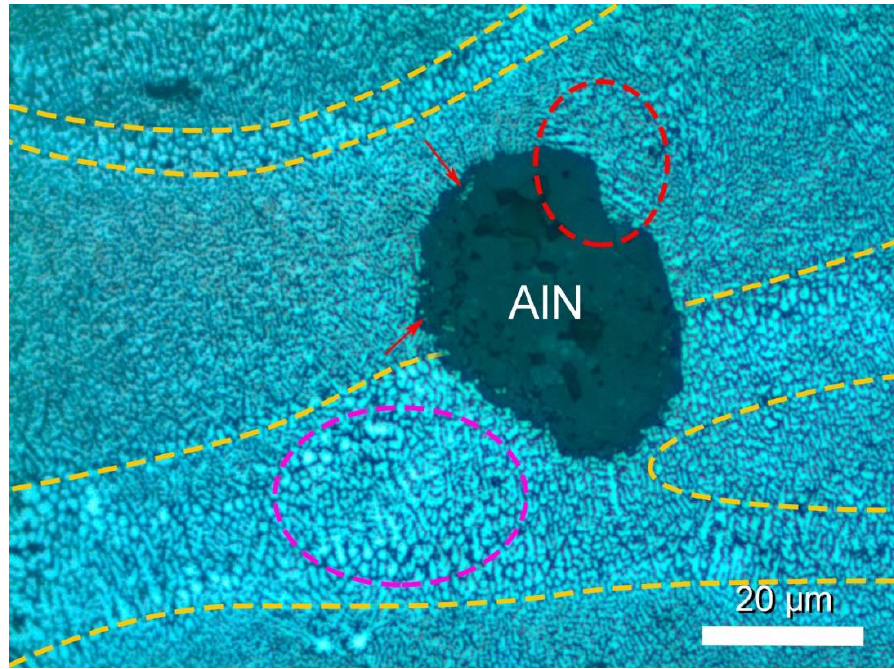
Figure 6. Optical microscopy image of the etched surface of AlSi10Mg/AlN composite after LPBF. The region highlighted by purple circle consists mostly of coarse cells caused by remelting during the LPBF process and, thus this region was reheated after solidification which induced the recrystallization process. Such a region is usually named a heat-affected zone (HAZ). HAZs are also located along each MPB (highlighted by yellow zone (HAZ). HAZs are also located along each MPB (highlighted by yellow regions) inside regions) inside neighboring previous scanned track and could be seen near MPB at the «bottom» of each MP in Figure 6. MP in Figure